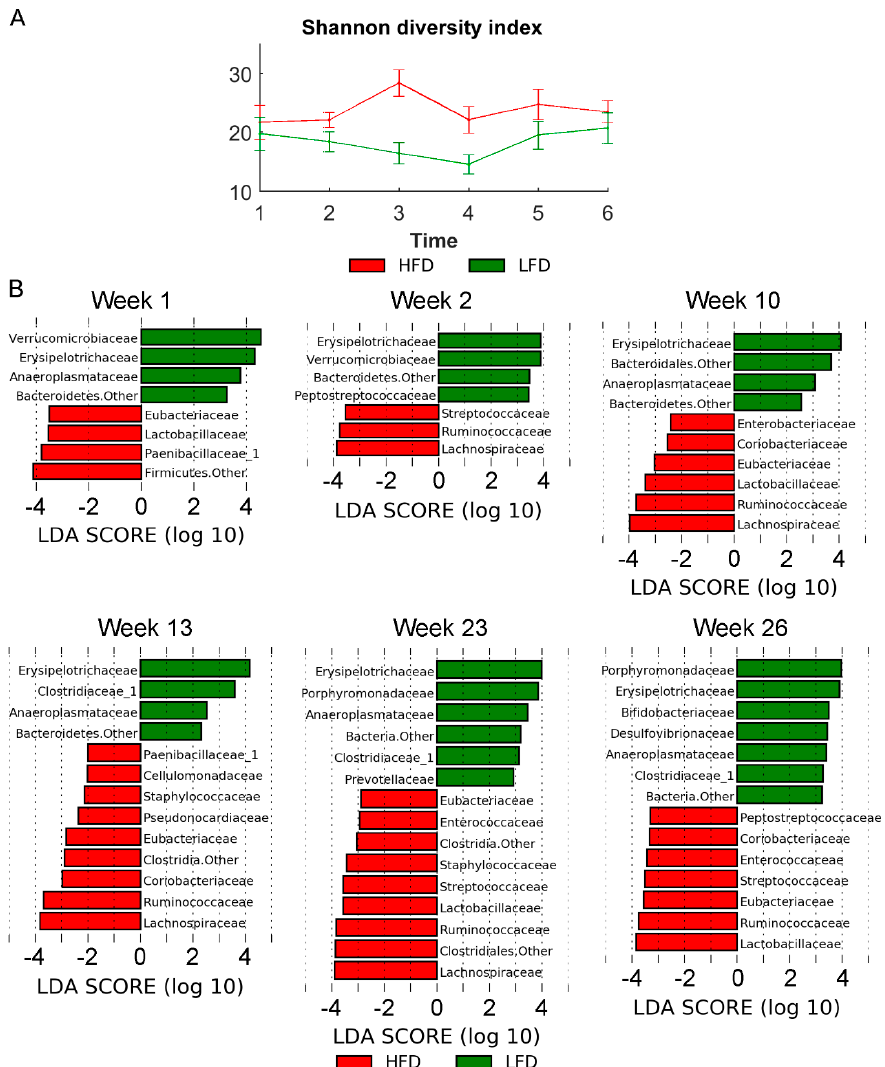
Figure 5. ( A ) α -diversity (Shannon diversity index). ( B ) Histograms showing the log-transformed Linear discriminant analysis (LDA) scores computed with Linear discriminant analysis effect size (LEfSe) for significantly different bacterial taxa between diet groups at the different sampling time points. A positive LDA score indicates enrichment in LFD, whereas a negative LDA score indicates enrichment in HFD. The LDA score indicates the effect size and ranking of each bacterial taxon. Statistical significance was evaluated using the Kruskal–Wallis test (alpha < 0.05) and a log-transformed LDA score with a threshold of 2.0. Error bars indicate the standard deviation of biological replicates ( n = 10). Abbreviations: LFD, low-fat diet; HFD, High-fat